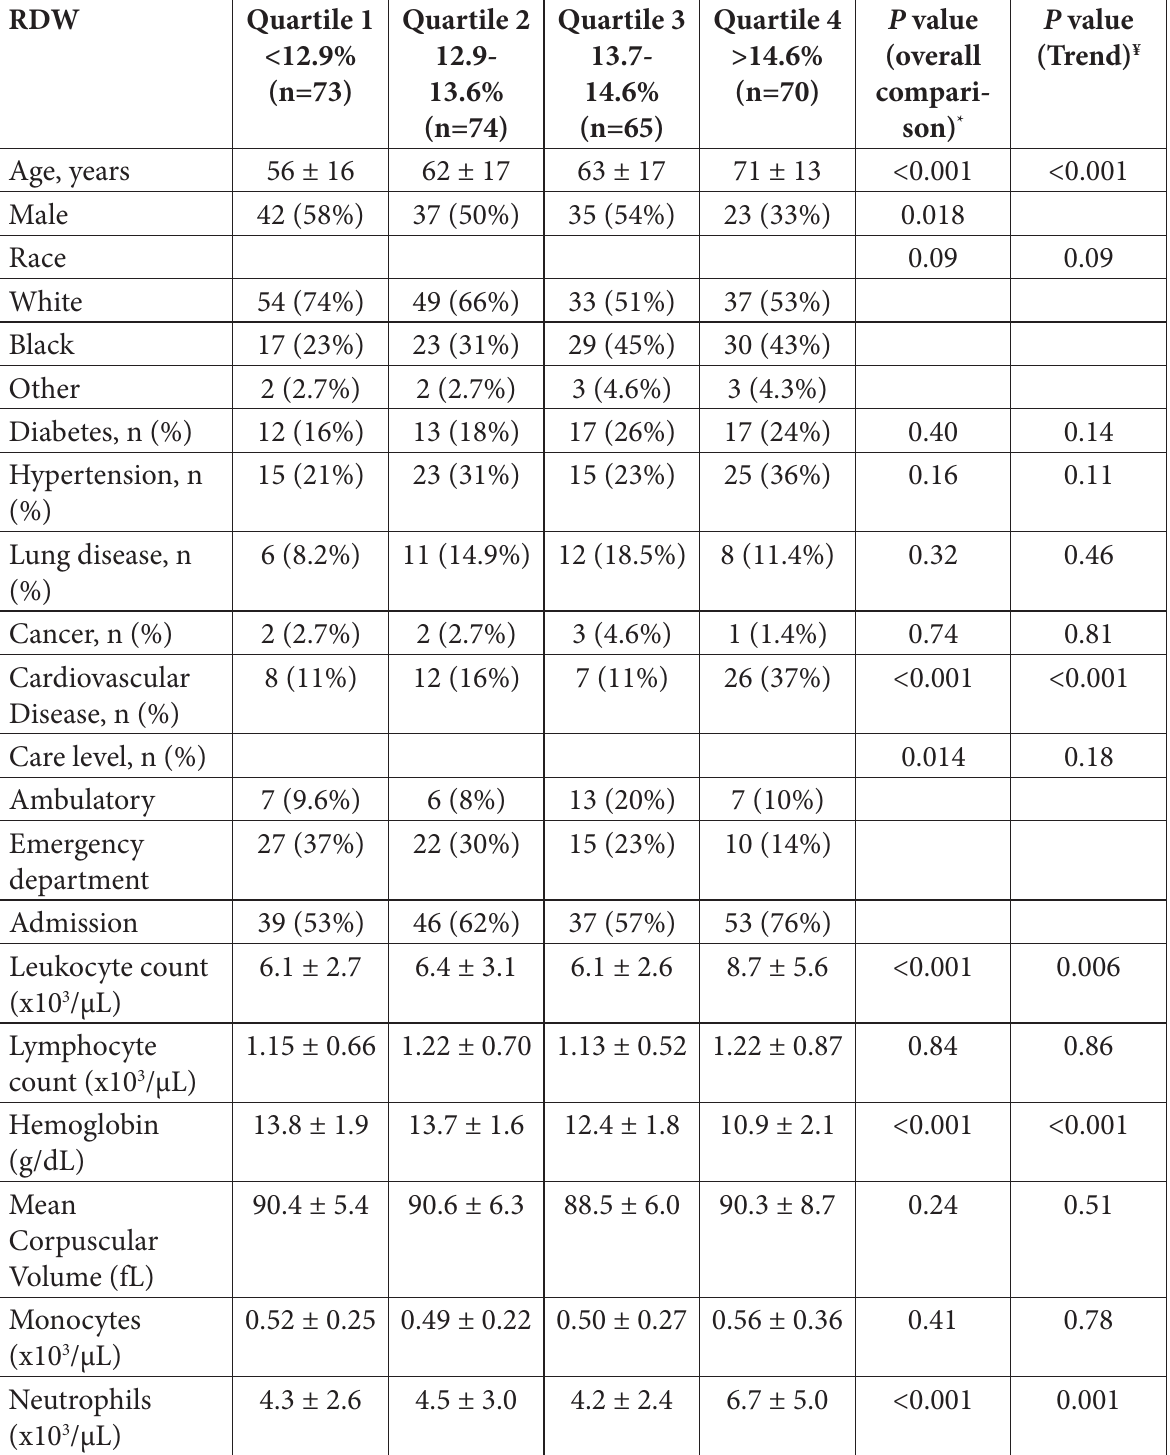
Table 1: Characteristics of Study Patients by Quartile of Red Cell Distribution Width (at Presenta-